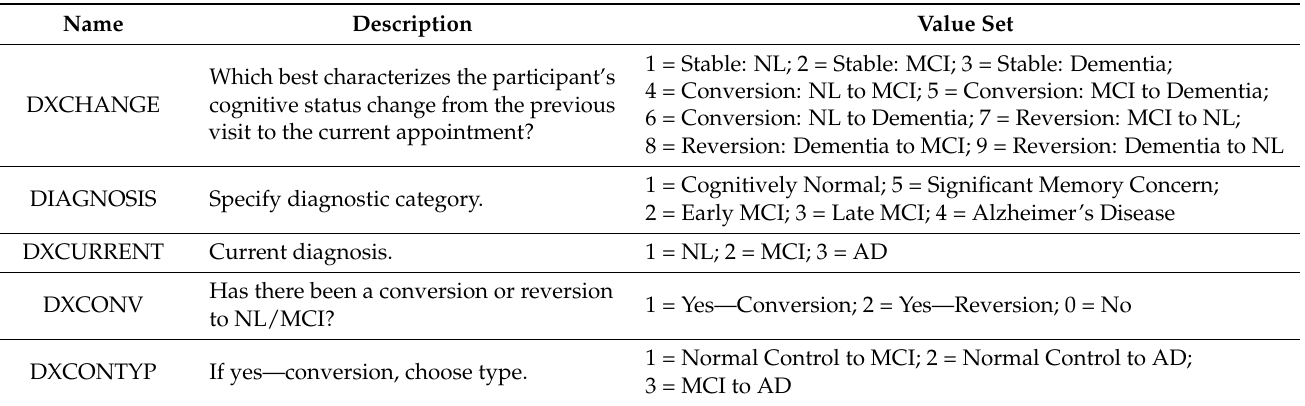
Table 2. Factors to consider while analyzing a diagnostic summary file. NL: normal control, AD: